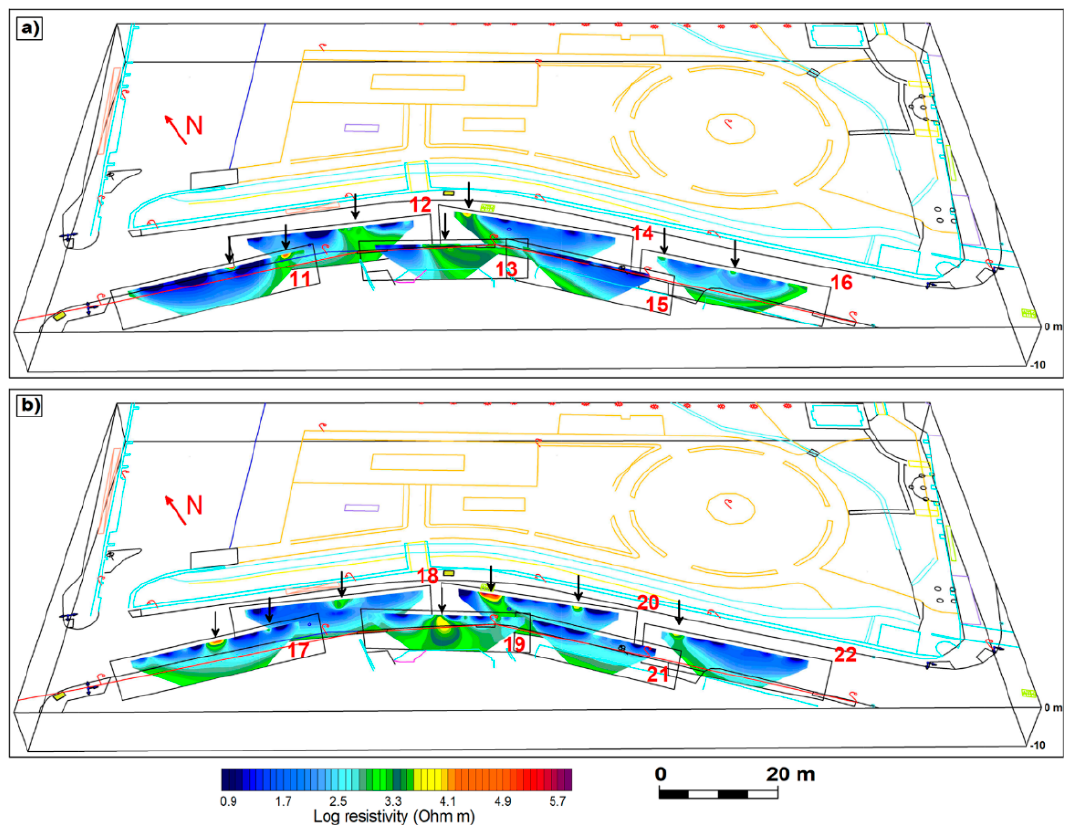
Figure 10. Omirou Avenue: 3D perspective views of ERT profiles 11–16 ( a ) and 17-22 ( b ).